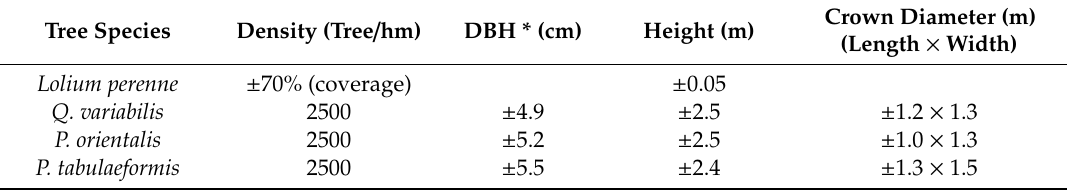
Figure 4. The layout situation of four lysimeters (photo by 2012.4.11). Table 2. Vegetation properties in lysimeter system.